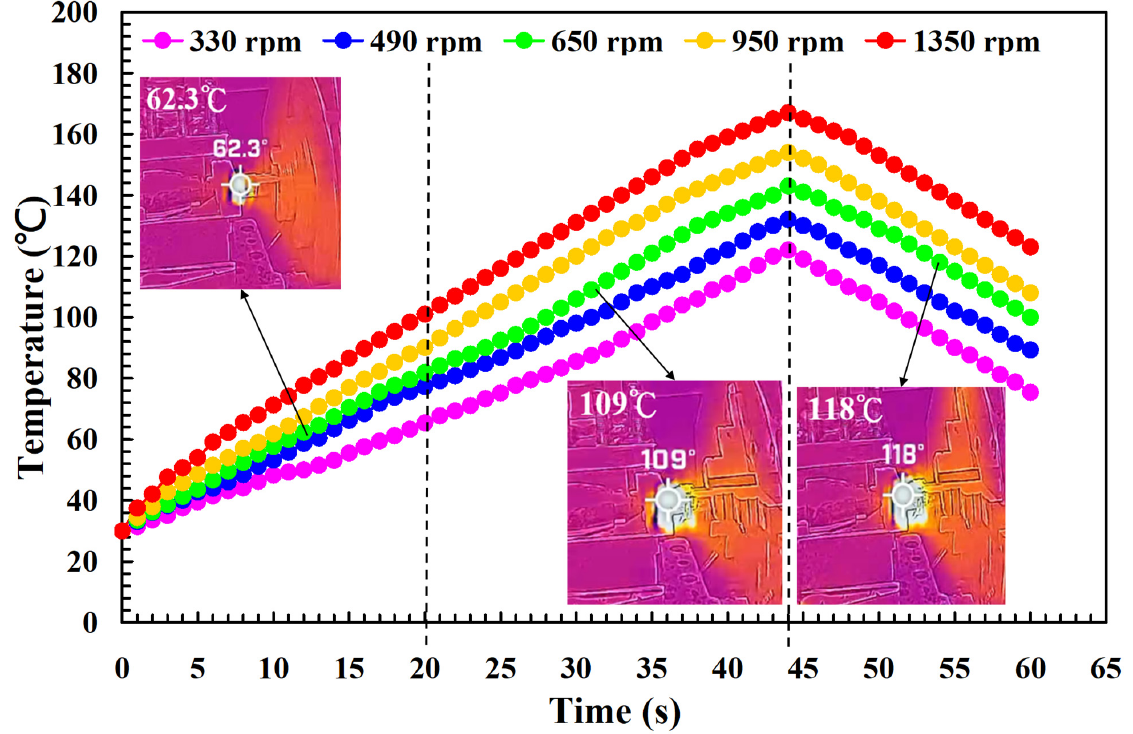
Figure 12. The relationship between weld-joint temperature and FW time for the PLA and PA rods at five different rotational speeds.